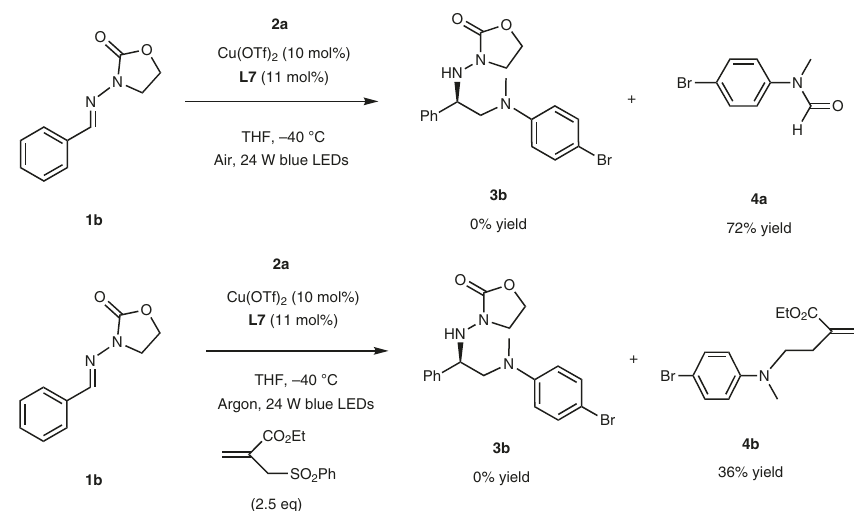
Fig. 4 Probing of the α -aminoalkyl radicals. Photocatalytic reaction interfered by air or a radical